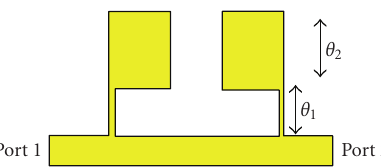
Figure 8: The proposed bandstop filter with stepped resonator structure.